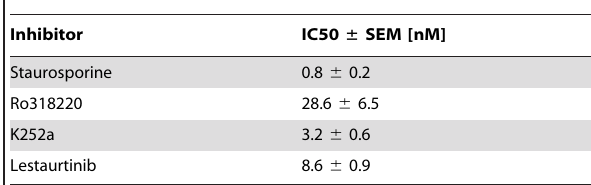
Table 1. PRK1 in vitro binding.